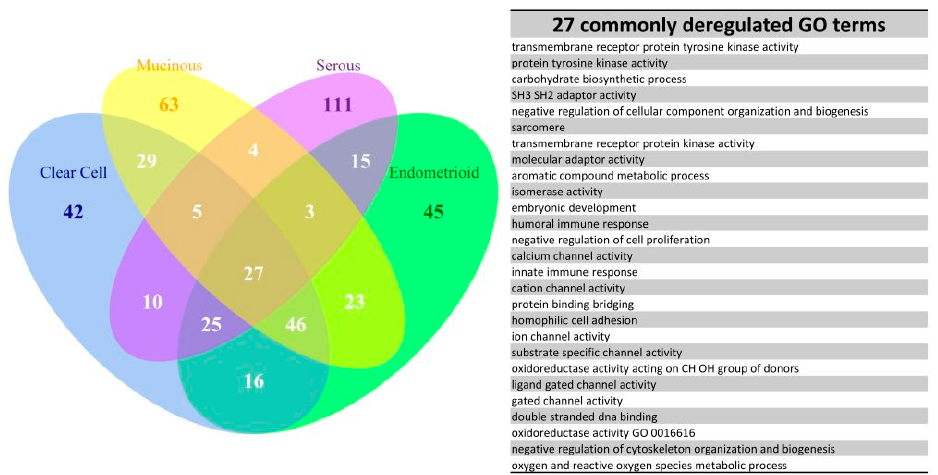
Figure 4. Venn diagram of the top 200 significantly deregulated GO terms for the four subtypes. The results of set analysis for the four ECO subtypes with the top 200 significantly deregulated GO terms ranked by the p values were displayed on the Venn diagram to show the gene set numbers of all possible logical relations among the four subtypes. The 27 common deregulated GO terms among the four subtypes were listed on the right side of the diagram.